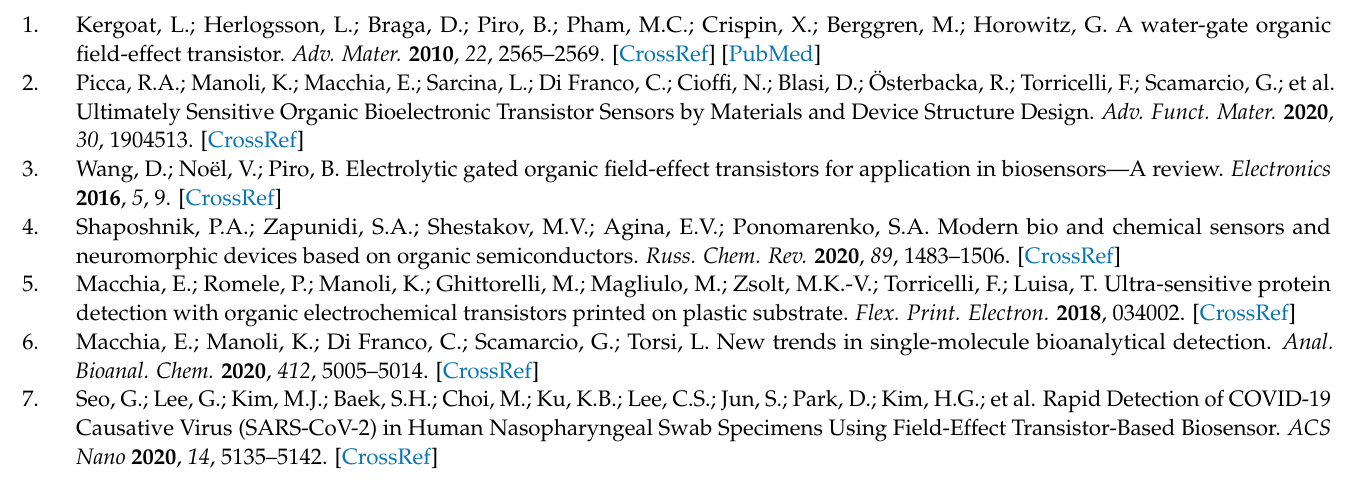
frame) and the device contact (the upper right angle, framed with a yellow triangle): (a) topology, (b) cross-section through white line 1. Figure S2. The transfer characteristics of an EGOFET including both IDS (red curve) and IGS (black curve) registered in 0.1 M NaCl after stabilization for a typical device. Figure S3. Electrical parameters degradation of an EGOFET during cyclic measurements: (a) the threshold voltage; (b) the transconductance; (c) the off current; (d) the gate current. Figure S4. (a) The pH dependence of the threshold voltage shift during addition of HCl acid (forward, from 20 to 50 min) and NaOH solution (backward, from 50 to 80 min). (b) Variations of the on-current during successive replacements of the electrolyte from a solution with pH = 5.8 to a solution with pH = 2 and vice versa for 9 successive measurements. Figure S5. The pH dependence in basic solutions (during NaOH addition) of (a) the off-current shift; (b) the normalized transconductance shift. The data were obtained with devices manufactured on a Si/SiO 2 substrate and averaged over 4 different EGOFETs. Figure S6. The pH dependencies of (a) the off-current shift; (b) the normalized transconductance shift. The data were obtained with the devices manufactured on a PEN substrate and averaged over 4 different EGOFETs. Figure S7. The transfer characteristics of an EFOFET in the flow chamber during 24 h long continues measurements: at the first measurement (circles), after 2 h (triangles), after 12 h (squares) and after 24 h